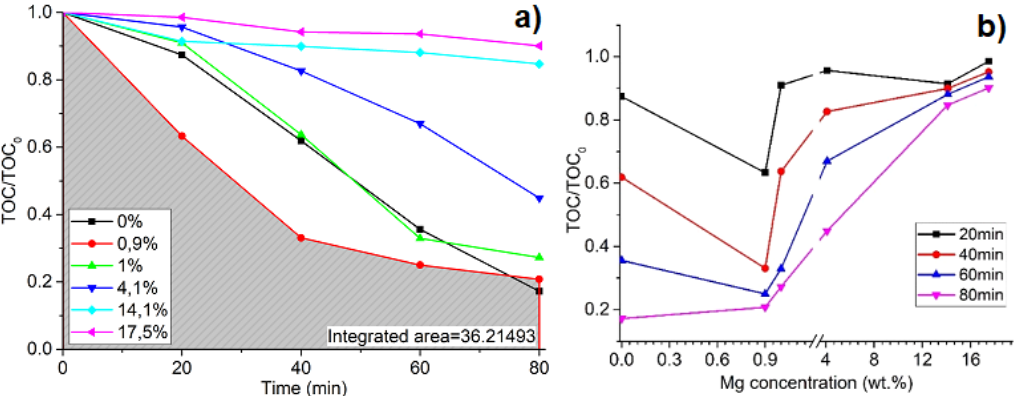
Figure 6. Degradation of oxalic acid in time as a function of Mg concentration in TiO 2 thin films, where ( a ) degradation of oxalic acid in time at different Mg wt % concentrations and ( b ) photocatalysis process dependence on Mg wt % dopant concentration .